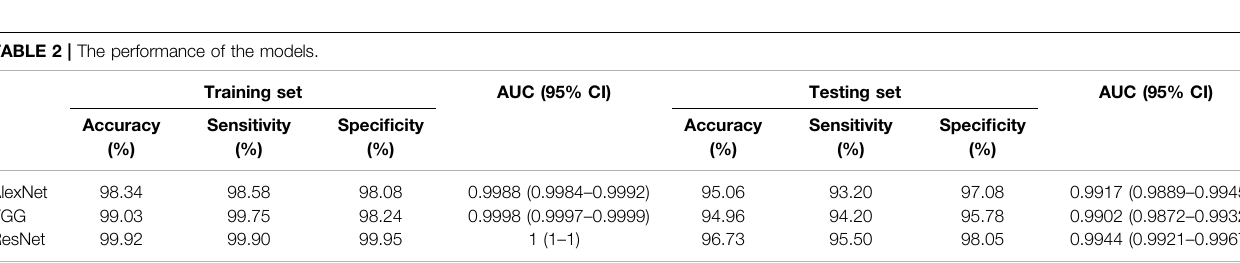
TABLE 2 | The performance of the